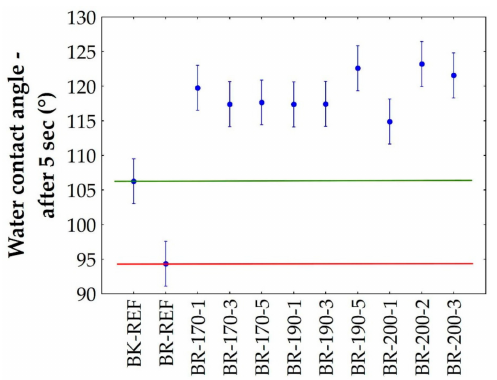
Figure 11. The graphic visualization of the e ff ect of heat-treatment temperature and heat-treatment time limit (peak stage) on wetting parameter (water contact angle—after 5 s) with label of values from the untreated birch (red line) and untreated beech (green line). BR-REF = untreated birch; BR-170-1 = birch treated at 170 ◦ C / 1 h; BR-170-3 = birch treated at 170 ◦ C / 3 h; BR-170-5 = birch treated at 170 ◦ C / 5 h; BR-190-1 = birch treated at 190 ◦ C / 1 h; BR-190-3 = birch treated at 190 ◦ C / 3 h; BR-190-5 = birch treated at 190 ◦ C / 5 h; BR-200-1 = birch treated at 200 ◦ C / 1 h; BR-200-2 = birch treated at 200 ◦ C / 2 h; BR-200-3 = birch treated at 200 ◦ C / 3